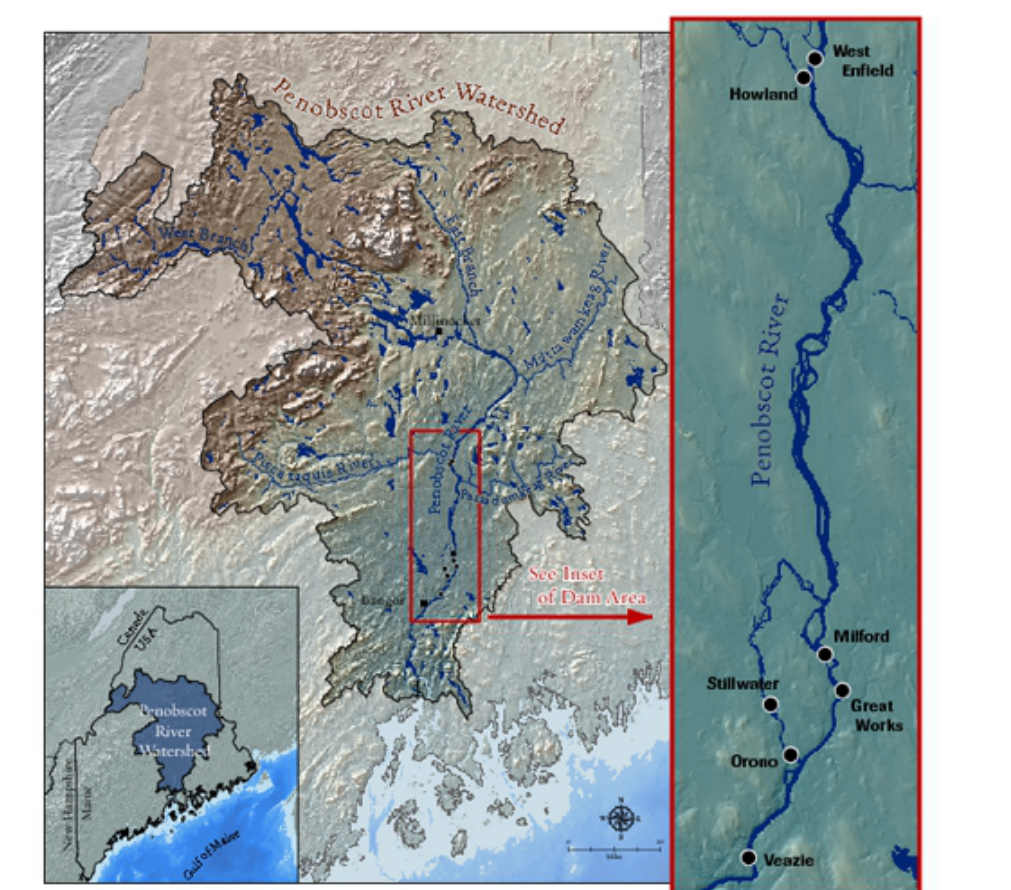
Fig. 1. Map of Penobscot